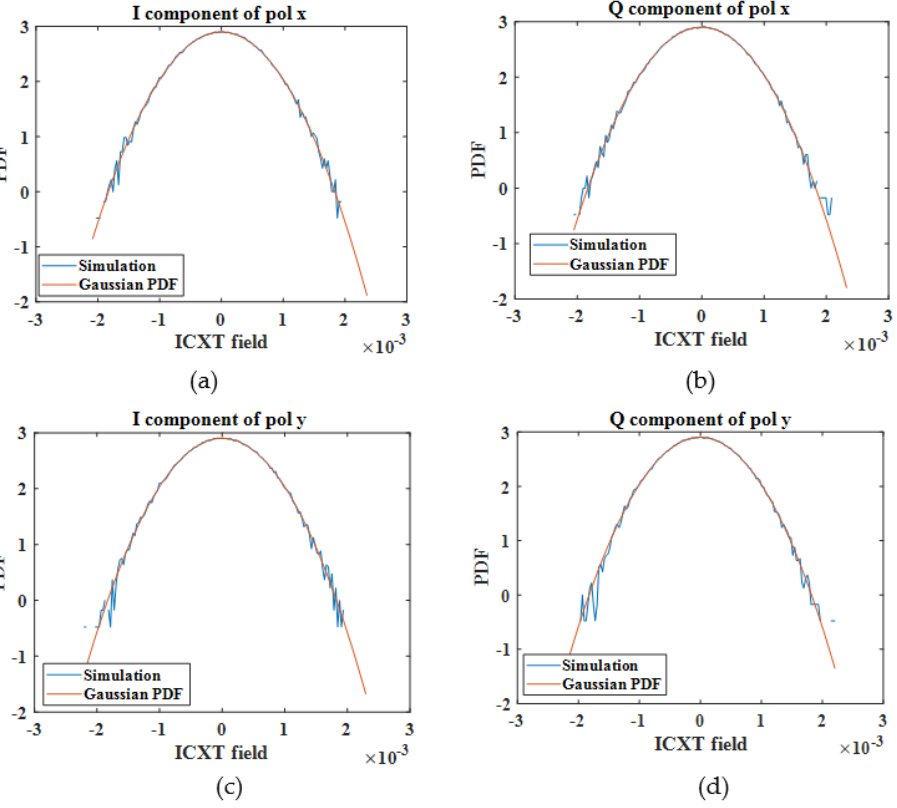
Figure 3. PDF of the quadrature components of the ICXT in x and y polarization. ( a , b ) ICXT fields of polarization x. ( c , d ) ICXT fields of polarization y .